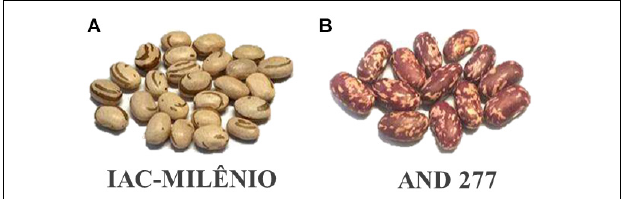
FIGURE 1 | The AM BC 2 F 3 mapping population parents: (A) IAC-Milênio, the Mesoamerican recurrent and susceptible parent; (B) AND 277, the Andean donor and resistant